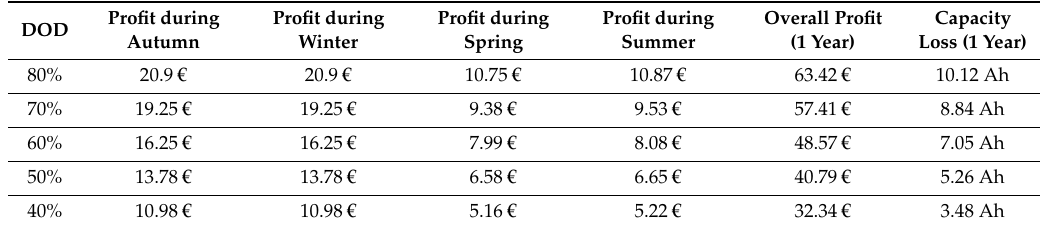
Table 3. Multi-season simulated scenario’s